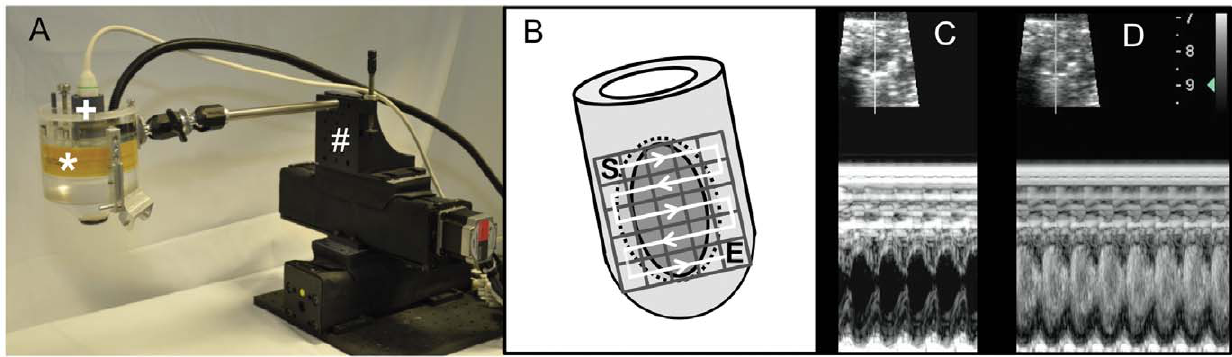
Figure 2. Therapeutic imaging probe system (TIPS) for ultrasound mediated stimulation of microbubbles. (A) Hybrid ultrasound probe system with electromechanically coupled diagnostic ( + ) and therapeutic probe (*) enabling simultaneous high-resolution imaging for targeted application of UMS. To allow a standardized application to a small, moving target organ, the system is coupled to a computer-programmed stepper motor ( # ). (B) ‘‘En face’’ heart model to visualize the computer-programmed grid on the anterolateral heart wall. The grid consists of 25 pulses total, administered every 1 mm and 5 pulses per row, respectively starting basal (S) and following the white line to the apex till E (end). UMS was targeted on the anterior left-ventricular wall and the anterior borderzone tissue (area within the dotted circle) after anterolateral ischemia. (C) + (D) Ultrasound B-Mode (upper image) and M-Mode (lower image) short axis view before (C) and after (D) microbubble application in a mouse without myocardial infarction. Hence, this hybrid scanhead allows standardized and targeted myocardial delivery of UMS in mice.